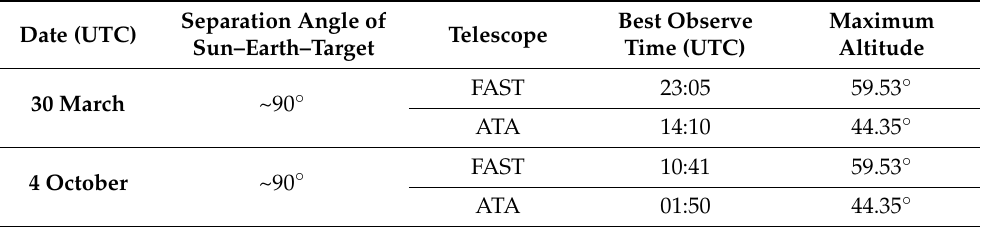
Table 1. A summary of optimal dates and times for FAST and ATA to transmit the BITG message. Separation Angle of Best Date (UTC) Telescope Sun–Earth–Target